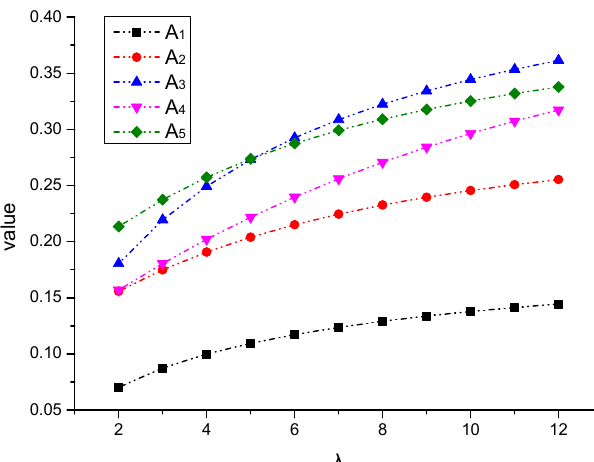
Figure 3. The influence of the change of λ value based on Gq-RONFWA operator on the sorting result.